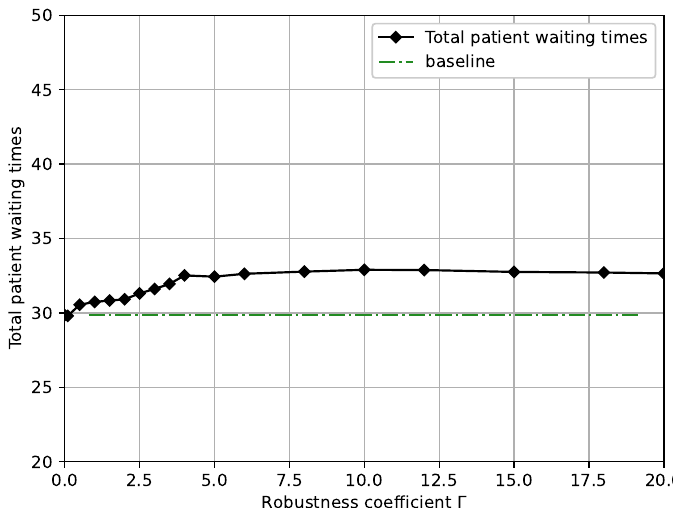
Figure 6. Total patients’ waiting time versus robustness coefficient Γ